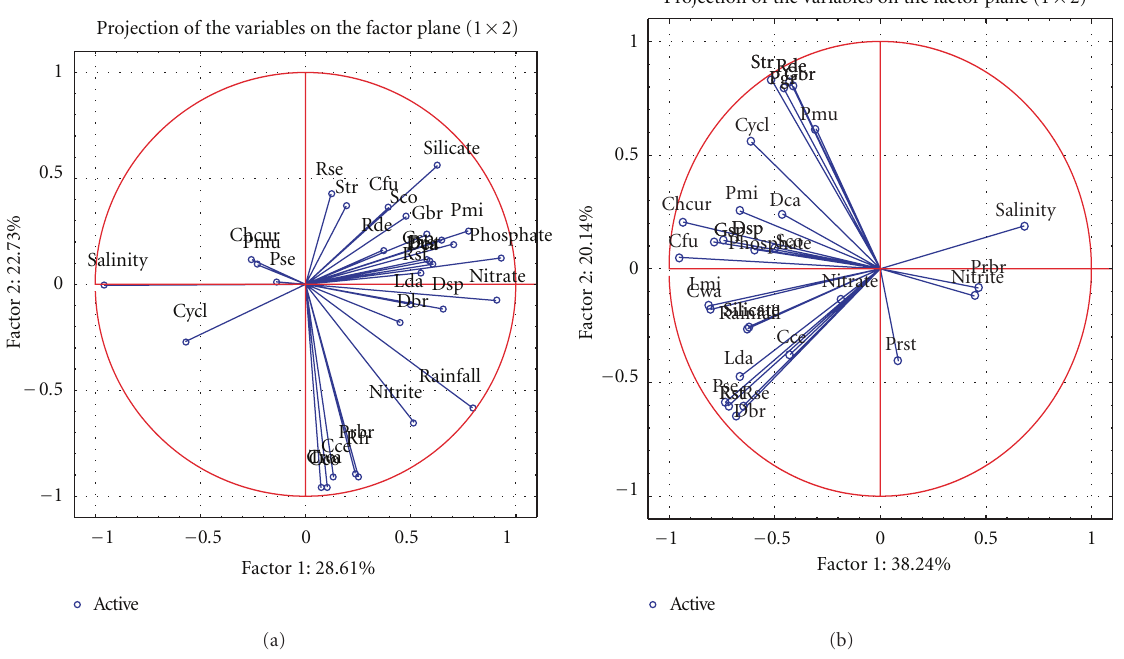
Figure 5: (a) PCA analysis of dominant harmful algal species abundance and physicochemical parameters in Mandovi estuary. Species acronyms: Chaetoceros curvisetum-Chur, Coscinodiscus concinnus-Cco, Coscinodiscus wailesii-Cwa, Coscinodiscus centralis-Cce, Cylindrotheca closterium-Cycle, Ditylum brightwellii-Dbr, Leptocylindrus danicus-Lda, Leptocylindrus minimus-Lmi, Pseudo-nitzschia multiseriata-Pmu, Pseudo-nitzschia seriata-Pse, Rhizosolenia delicatula-Rde, Rhizosolenia fragilissima-Rfr, Rhizosolenia setigera-Rse, Rhizosolenia stolterforthii- Rst, Skeletonema costatum-Sco, Thalassiosira rotula-Tro, Ceratium furca-Cfu, Dinophysis caudata-Dca, Gymnodinium breve-Gbr, Gymno- dinium splendens-Gsp, Prorocentrum gracile-Pgr, Prorocentrum micans-Pmi, Protoperidinium brevipes-Prbr, Protoperidinium steinii-Prst, Scrippsiella trochoidea-Str, and Distephanus speculum-Dsp. (b) PCA analysis of dominant harmful algal species abundance and physicochemical parameters in Zuari estuary. Species acronyms: Chaetoceros curvisetum-Chur, Coscinodiscus wailesii-Cwa, Coscinodiscus centralis-Cce, Cylindrotheca closterium-Cycl, Ditylum brightwellii-Dbr, Leptocylindrus danicus-Lda, Leptocylindrus minimus-Lmi, Pseudo- nitzschia multiseriata-Pmu, Pseudo-nitzschia seriata-Pse, Rhizosolenia delicatula-Rde, Rhizosolenia setigera-Rse, Rhizosolenia stolterforthii- Rst, Skeletonema costatum-Sco, Ceratium furca-Cfu, Dinophysis caudate-Dca, Gymnodinium breve-Gbr, Gymnodinium splendens-Gsp, Prorocentrum gracile-Pgr, Prorocentrum micans-Pmi, Protoperidinium brevipes-Prbr, Protoperidinium steinii-Prst, Scrippsiella trochoidea-Str, and Distephanus